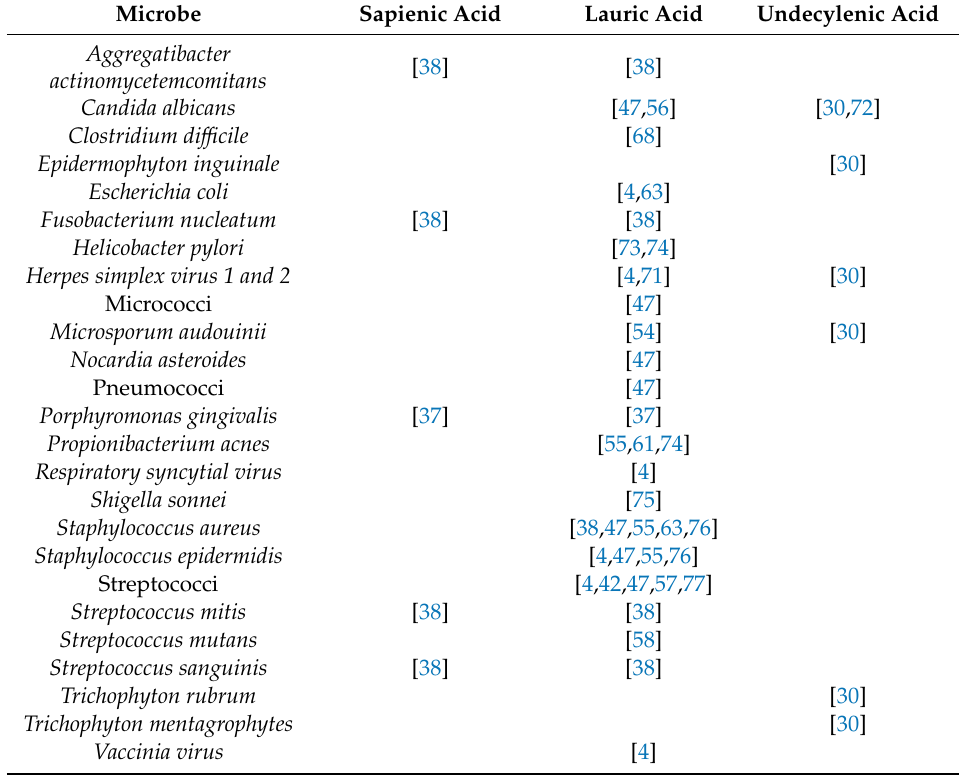
Table 2. Innate free fatty acids exhibit antimicrobial activity against a variety of opportunistic bacteria, viruses, and fungi. Lauric acid is the most broadly antimicrobial fatty acid of those naturally occurring on the skin, mucosal membranes, and in sweat. These data are summarized from multiple studies; however, huge variability in reporting of AML activity precludes the compilation of detailed concentrations into a single chart. Readers are referred to individual citations for specific concentration